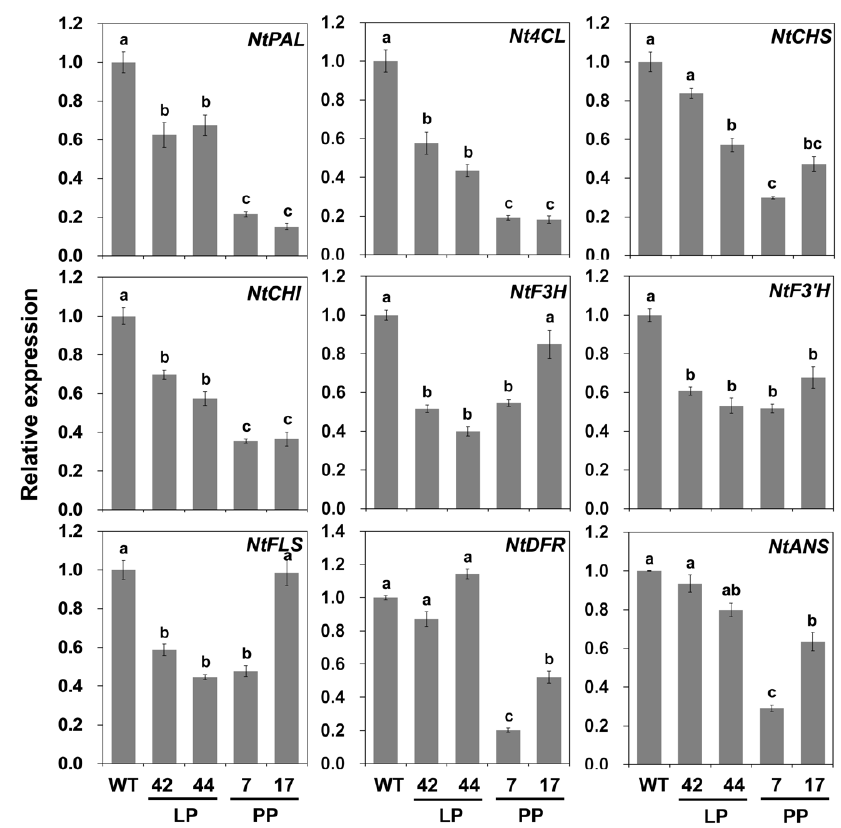
Figure 6. Expression patterns of flavonoid biosynthesis pathway genes in WT and AcFLS-HRB- expressing tobacco petals, as revealed by qPCR. LP, light pink transgenic lines; PP, pale pink transgenic lines. Error bars indicate ± SD from three replicates. Statistical significance was determined by one-way ANOVA with post-hoc Tukey’s tests. Significant differences between means ( p < 0.05) are indicated by lower-case letters (a, b, and c) above the bars.